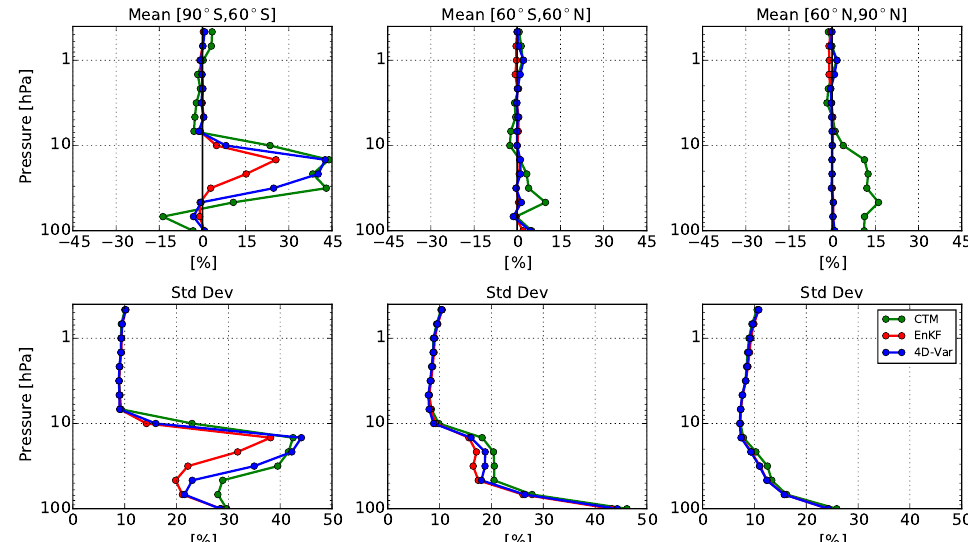
Figure 5. HCl OmF bias (top) and standard deviation (bottom) computed for the full chemistry CTM (green), EnKF (red) and 4D-Var (blue). OmF statistics are computed in percent with respect to the assimilated EOS Aura-MLS data for the period May–June 2008 and for three latitude bands (from left to right: South Pole, tropics–middle latitudes and North